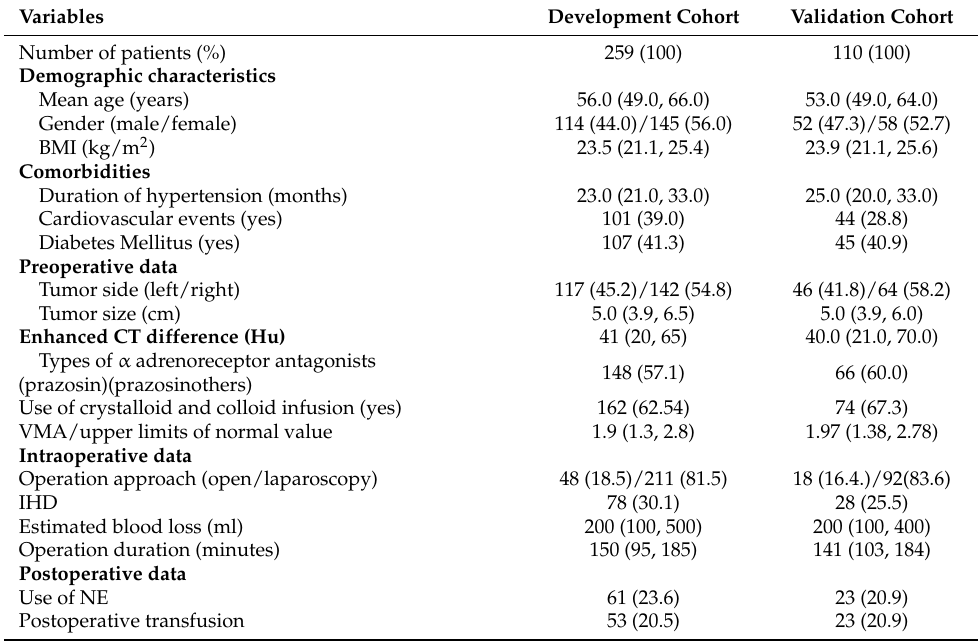
Table 1. Characteristics of patients in the development and validation cohort for this study.